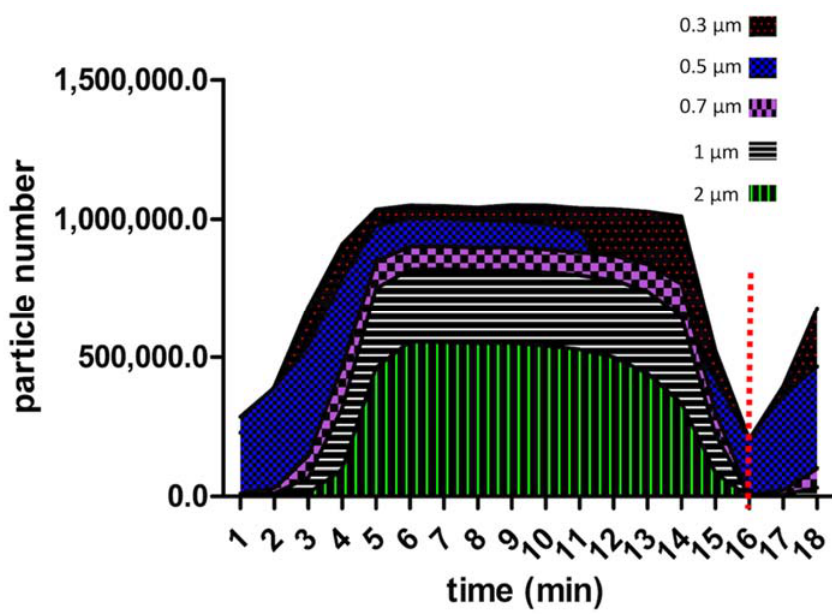
Figure 3. The particle number by time in the tent.